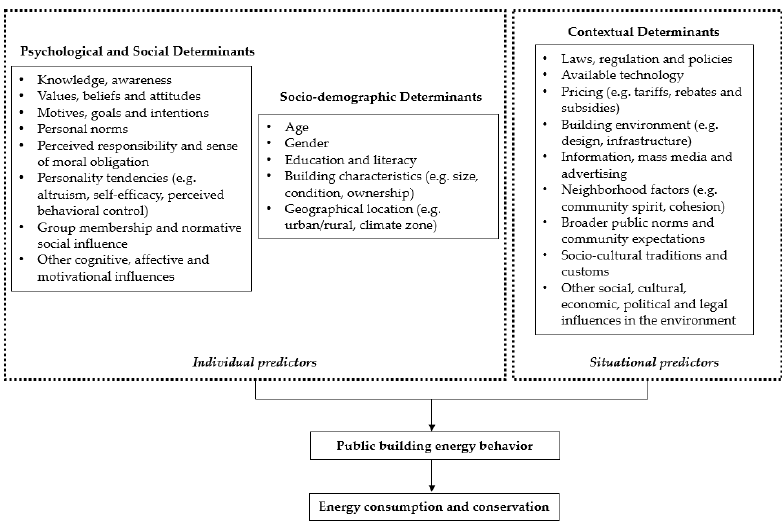
Figure 2. Determinants that may influence energy-saving behavior in public buildings. Adapted for public buildings in accordance with Frederiks, Stenner, and Hobman [39].